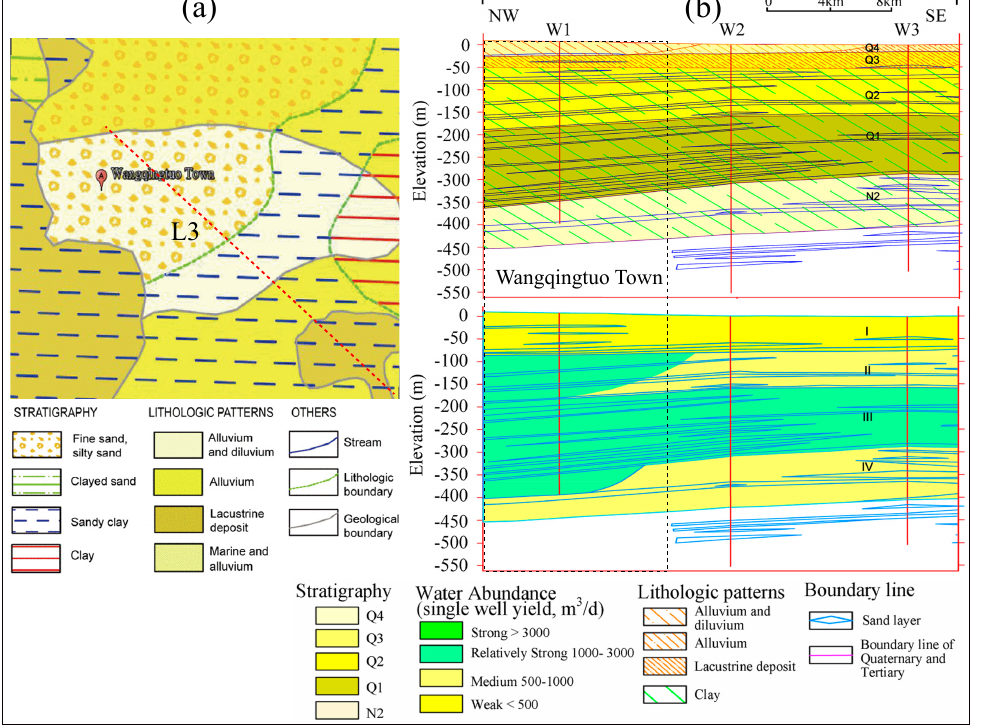
Figure 17. ( a ) Geological map of Wangqingtuo Town, ( b ) Geological profile map (above) and Hydrological profile map (below). The black box in panel b denotes the span in the direction from north-west to south-east, W1 denotes Wangqingtu Town, W2 and W3 denote Xiqing District, the red dotted line L3 in the panel a denotes the profile from W1 to W3. This figure is revised from